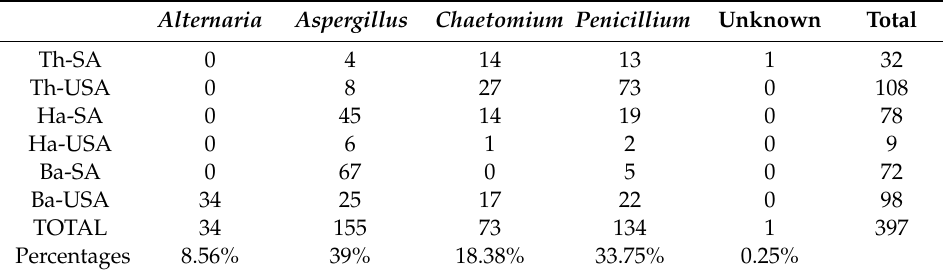
Table 1. Number of isolates of fungi per cultivar (Th, cv. ‘Thoory’; HA, cv. ‘Halawi’; Ba, cv. ‘Barhi’) and range (SA, Saudi Arabia; USA, American Southwest) for a total of 397 isolates per 600 seeds. Relative abundances are shown on the bottom line as percentages of the total number of isolates. Aspergillus here refers to Aspergillus sect. Nigri . Alternaria Aspergillus Chaetomium Penicillium Unknown Th-SA